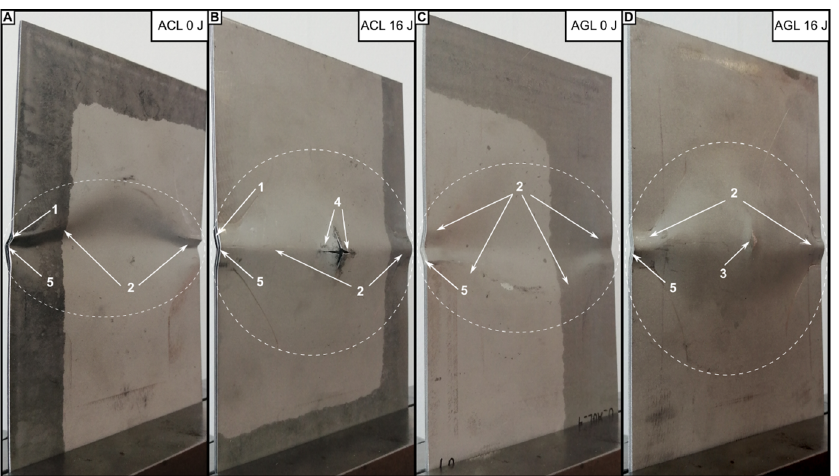
Figure 13. Macroscopic views of ACL ( A , B ) and AGL ( C , D ) laminates after critical failure in CAI test. The following damage forms were recognized: delaminations (1), plastic metal strain (2), metal cracks (3), post-impact petalling (4) composite layer failure (5). The perimeter of potential damage zone is marked with dashed lines.